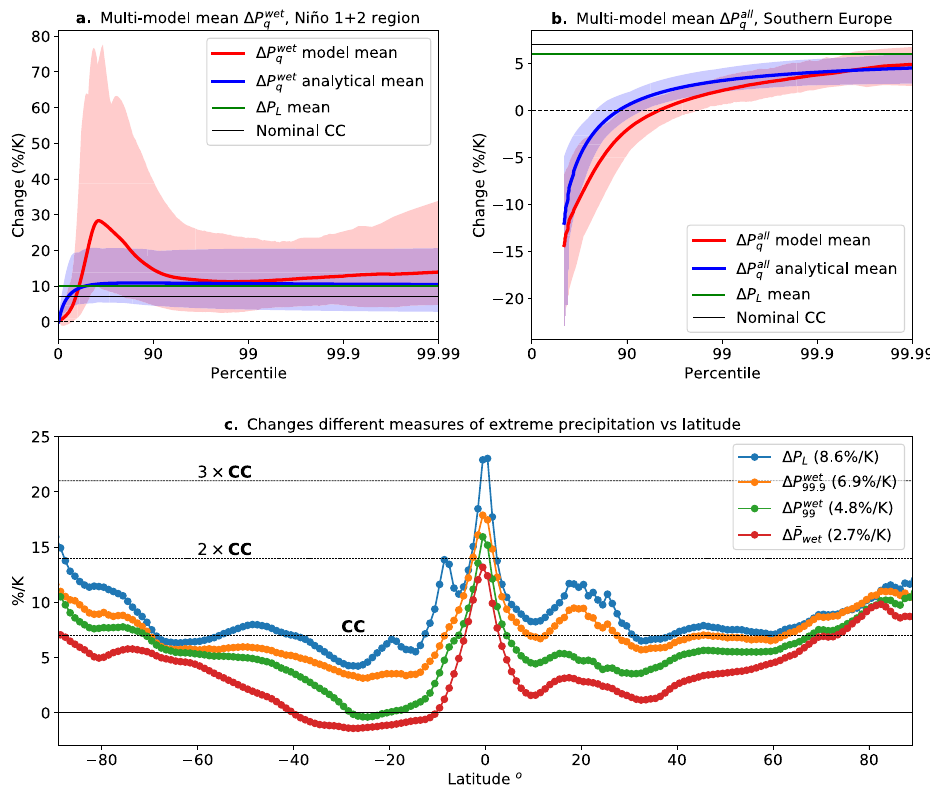
Figure 4. ( a ) Change in left-censored wet-day percentiles between 2075-2099 compared with 1990-2014 in the Niño 1+2 region (10 ◦ S-0 ◦ S, 90 ◦ W-80 ◦ W) where some models depart from observed PDF shape. Solid red represents the multi-model mean and shaded-red the 5–95th percentile across models. Solid blue represents the multi-model mean and shaded-blue the 5–95th percentile across models of the analytical change (see Methods) in left-censored wet-day percentiles. Changes in these percentiles are given by each model change in P L (multi-model mean shown as a horizontal green line) and τ P (see Eq. 2 and methods). The nominal CC change is shown as a horizontal black line. ( b ) Same as ( a ) but for changes in left-censored all-day percentiles in the Southern Europe region (40 ◦ N-50 ◦ N, 0 ◦ E-20 ◦ E). ( c ) Multi-model mean of the zonal average fractional change in P L , P wet 99.9 , P wet 99 , and ¯ P wet between 2075–2099 and 1990–2014. Numbers in parentheses show the multi-model mean global change in these quantities. Horizontal lines representing nominal CC , 2 × CC , and 3 × CC scaling are shown for reference. In all cases change is normalized by the average increase in global temperature in each model prior to